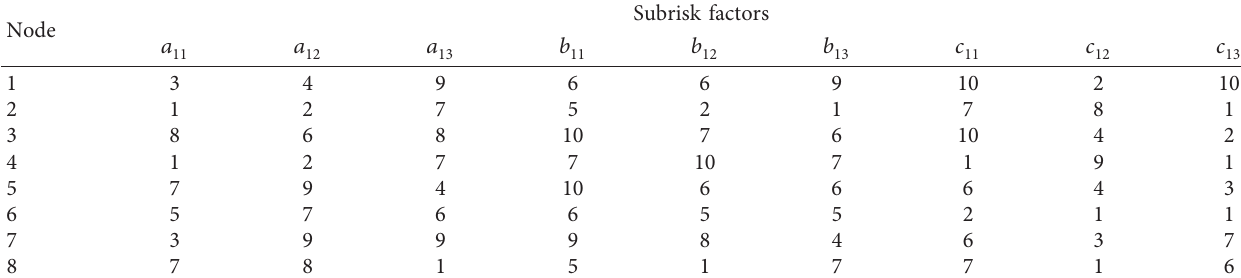
Table 7: Scoring results of subrisk factors of the first-level nodes.